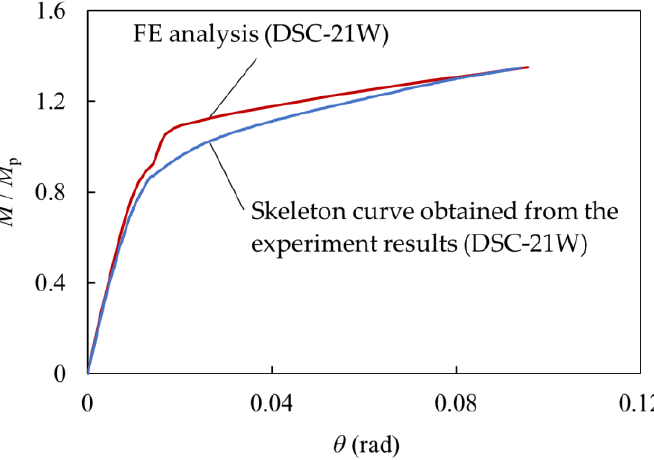
Figure 9. Typical mesh for FE Analysis.